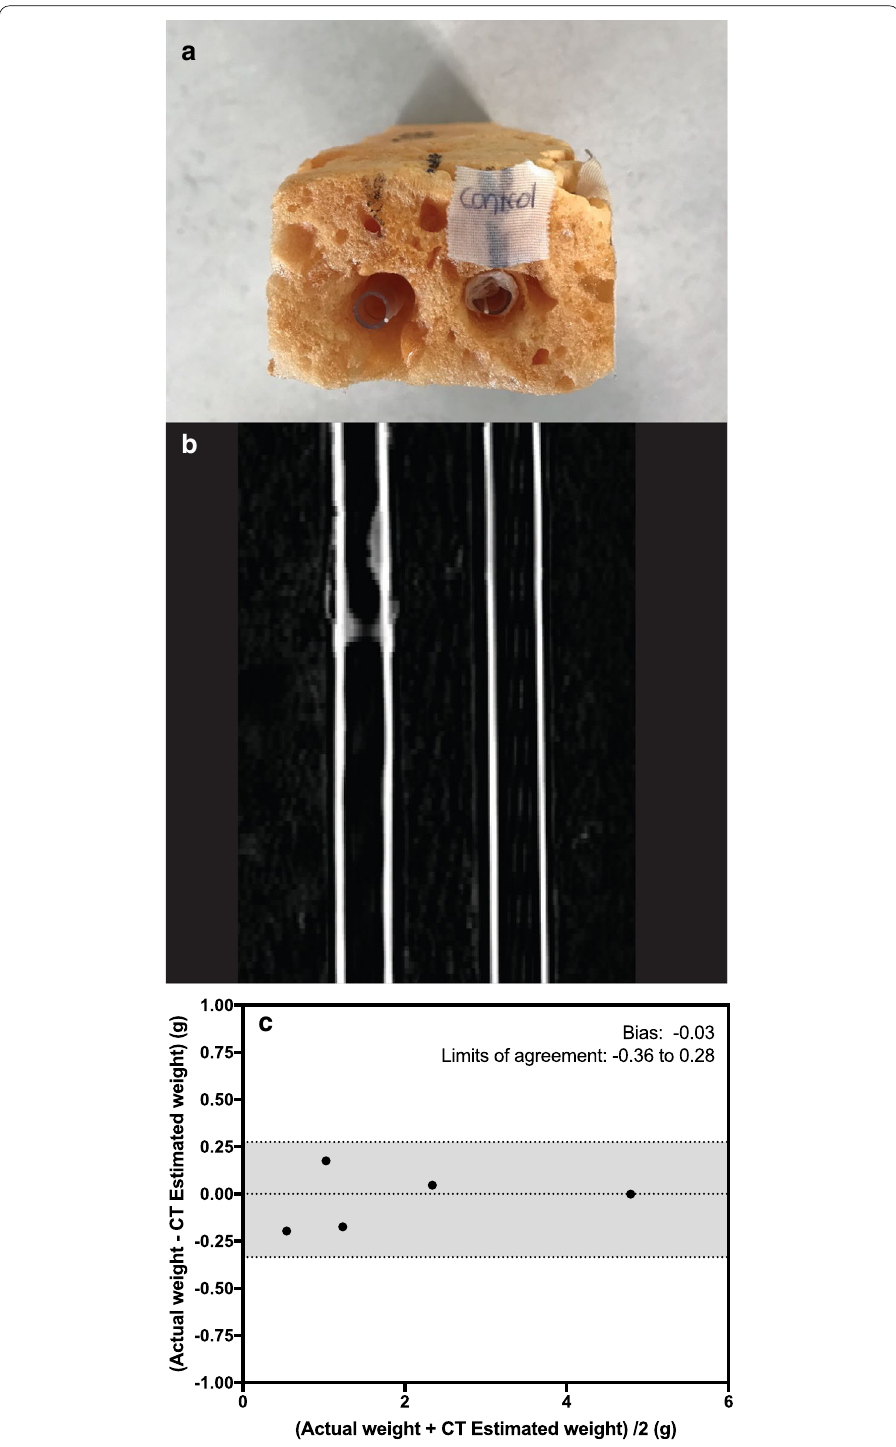
Fig. 1 Tube mold used for image acquisition ( a ) and corresponding computed tomography image ( b ) of a partially obstructed tube (left) and the control tube (right). Bland–Altman analysis between CT-estimated and scale-measured mucus weight using a threshold of 770 HU ( c ). CT, computed −